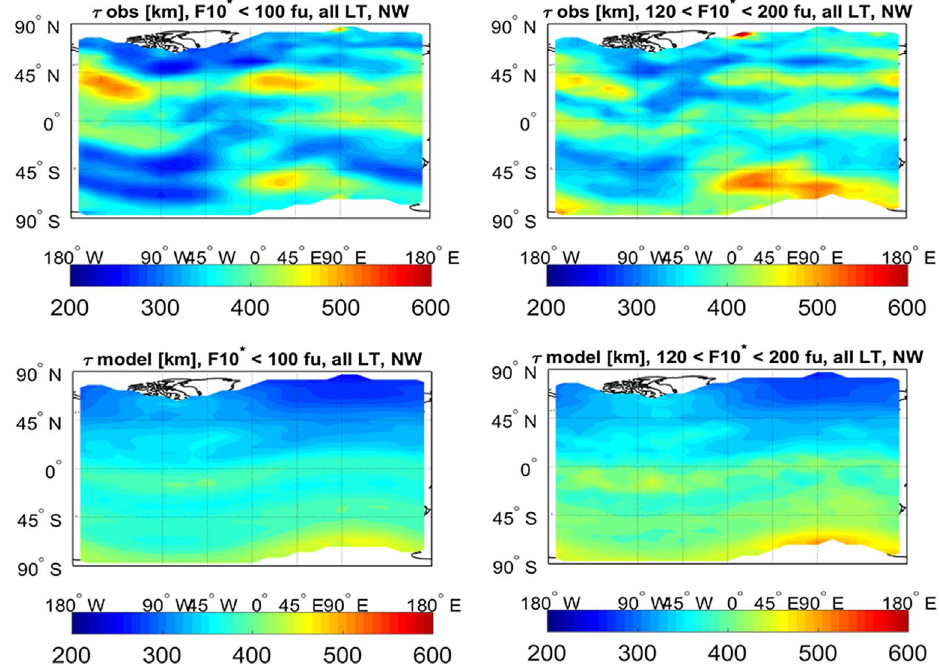
Fig. 6. Daily averaged global maps of observed and modelled s for LSA (left) and HSA (right) conditions for Northern winter (NW).